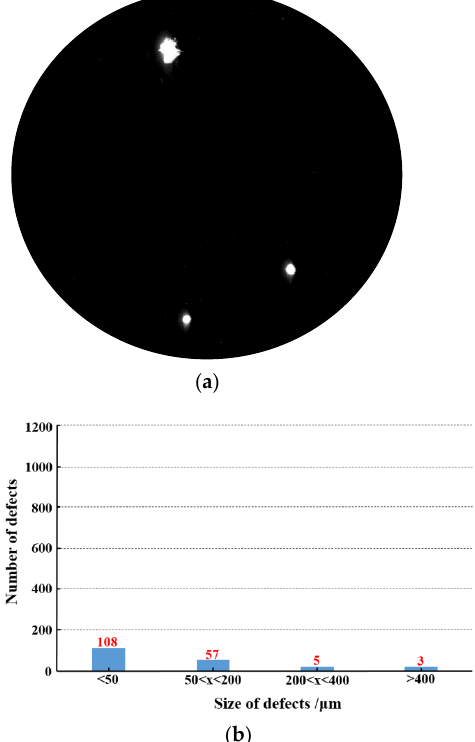
Figure 13. Results of surface defects after MRF polishing: ( a ) Laser scattering detection results; ( b ) The number of defects. After the MRF polishing process, the number of surface defects greatly reduced, the number of small- scale defects (<50 μm) decreased from 1116 to 106, and the defect suppression coefficient was 90.32%, which reached the target as stated in Section 3.2. At the same time, the number of defects (50 μm < × < 200 μm) also decreased significantly, from 106 to 57. The number of defects with larger sizes had no obvious change before and after MRF polishing. It was believed that MRF polishing has poor inhibition ability for defects with larger scale (>200 μm), and a CO 2 laser process could be used to passivate them later. 4. Discussion In this work, a BP neural network combined with the MRF technique was used to suppress the defects within a certain scale on the surface of damaged fused silica optics and achieved remarkable results. However, there are still many phenomena to be discussed. As shown in Section 3.1, the damage threshold test platform was used to prepare the damaged optics instead of using the optics banned from the Shenguang device. As for the real optics banned from the Shenguang device, their caliber is basically beyond 300 mm, and they have to be stored appropriately to avoid flowing to other institutions. Therefore, it is very difficult to obtain damaged optics from the device. The operating parameters of the Shenguang device can be obtained from relevant studies. Therefore, it is feasible to prepare the optics by ourselves. Except for the difference in the illuminance area of the laser, other operating parameters can be strictly controlled. The difference in laser will not strongly affect the damage types, the damaged optics prepared by the laser damage test platform can be applied in this work and the results still have a powerful reference value. For the laser scattering device, which was developed by ZC Co., Ltd., the resolution and accuracy are high after being checked by the company. In Figures 5, 6, 12 and 13, the damage points can be obviously found in the testing area, and the changes in the surface before and after the MRF process can also be easily obtained even though the size of the defects is very small (about a few microns). It should be noted that some testing results are in situ, which also verifies the accuracy. Based on the testing results and characteristics of the device, it can be proven that the device can be applied in this work and the testing results have strong credibility. From Figure 5 and Table 3, it can be seen that the number of small-scale defects decreases rapidly, which indicates that small-scale defects are removed during the MRF process. As for large-scale defects, their number does not change obviously. In Figure 14, it could be seen that the small-scale defects around larger damage points were removed absolutely, and the large-scale damage point was mitigated. After the MRF process, the profile of the damage points became fuzzy, which was linked to the material removal, and